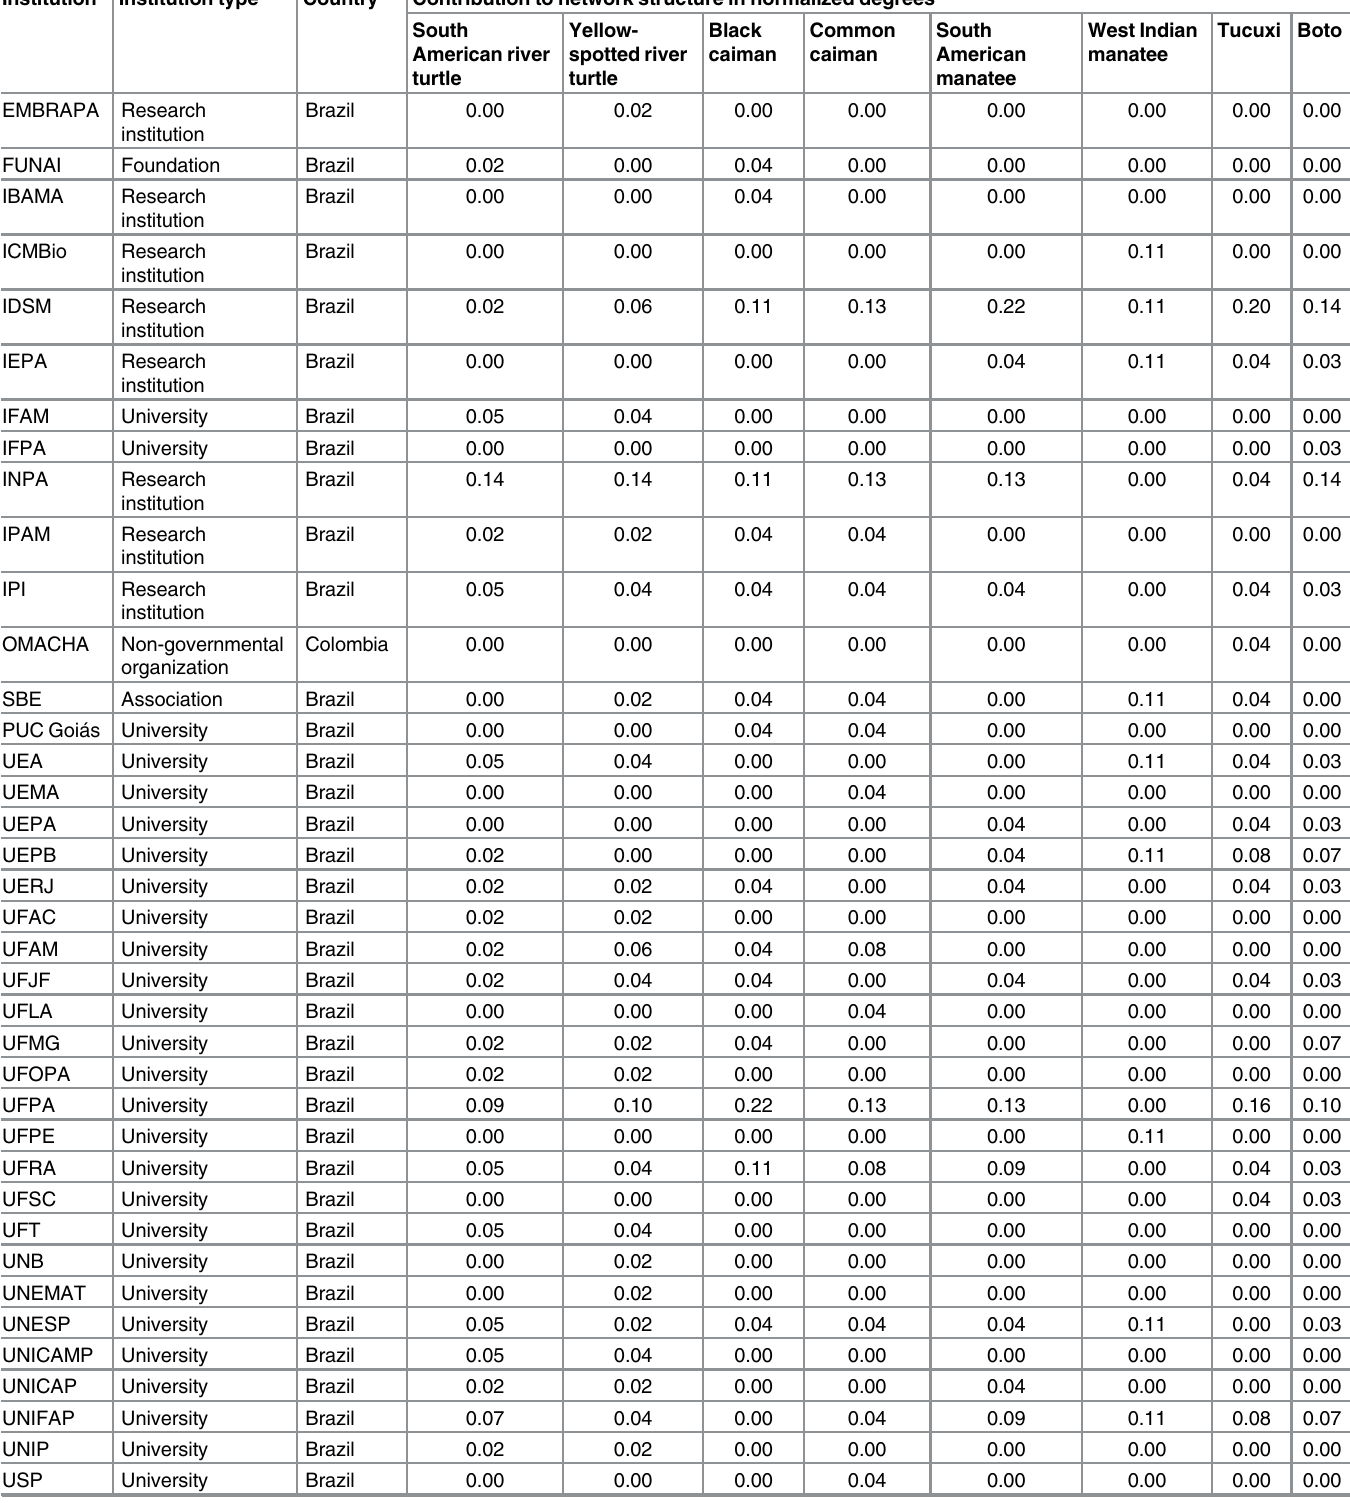
Table 2. List of Amazonian aquatic species obtained from 105 studies published from 1990 to 2014 that were studied by each institution, institution type, and country, and contributions of species-institution combinations to the scientific collaboration network measured in normalized